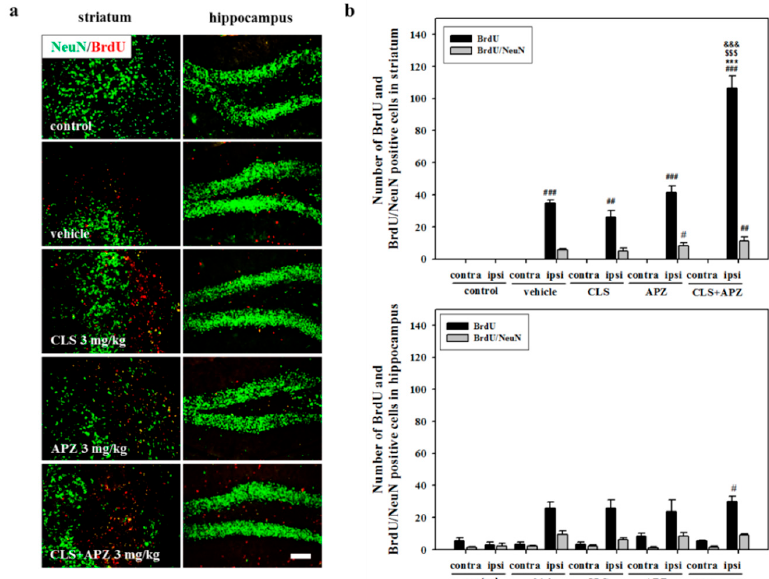
Figure 4. Effect of APZ augmentation on proliferation and differentiation from neuronal progenitor cells in CLS-treated mice. Photomicrograph ( a ) and its histogram ( b ) for 5-bromo-2 ′ -deoxyuridine (BrdU) and BrdU/NeuN-double positive cells in the striatum and hippocampus ( n = 5). The combined use of APZ and CLS significantly increased the number of BrdU-positive cells in the striatum compared to vehicle-, CLS-, and APZ-treated mice. Contra, contralateral; ipsi, ipsilateral. # p < 0.05, ## p < 0.01 and ### p < 0.001 versus control mice; *** p < 0.001 versus vehicle-treated mice; $$$ p < 0.001 versus CLS-treated mice; &&& p < 0.001 versus APZ-treated mice. Scale bars = 100 μ m.